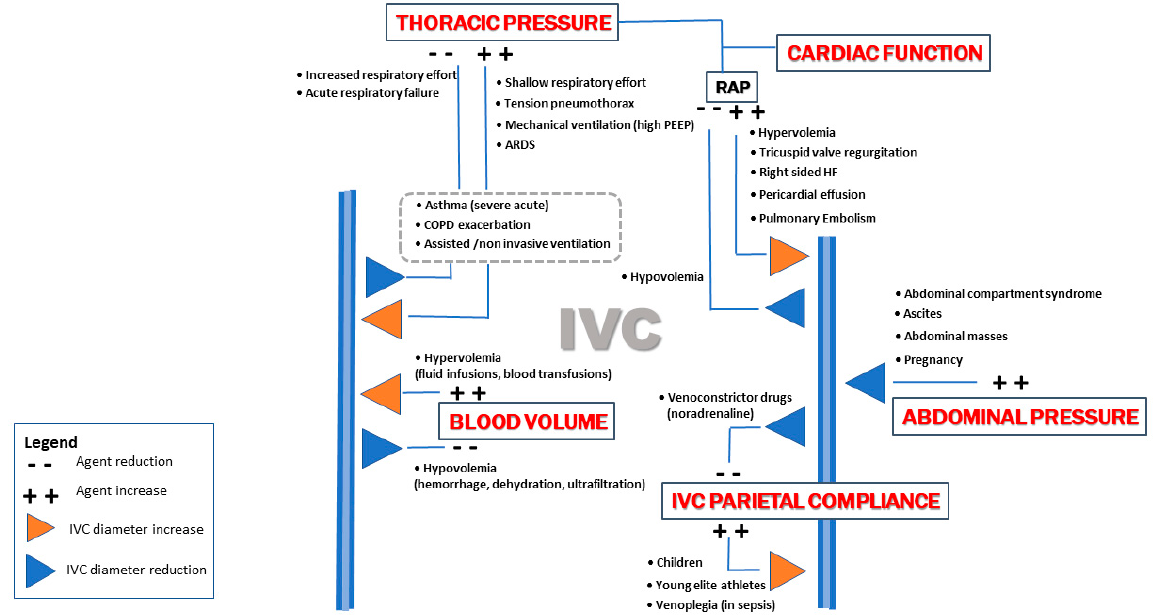
Figure 1. Main determinants affecting inferior vena cava diameter. Chest pressure can act directly and/or indirectly (via the RAP) on IVC diameter. The clinical conditions within the grey dashed rectangle can correlate with both types of chest pressure variations. (ARDS: acute respiratory distress syndrome, COPD: chronic obstructive pulmonary disease, HF: heart failure, IVC: inferior vena cava, PEEP: positive end-expiratory pressure, RAP: right atrial pressure).